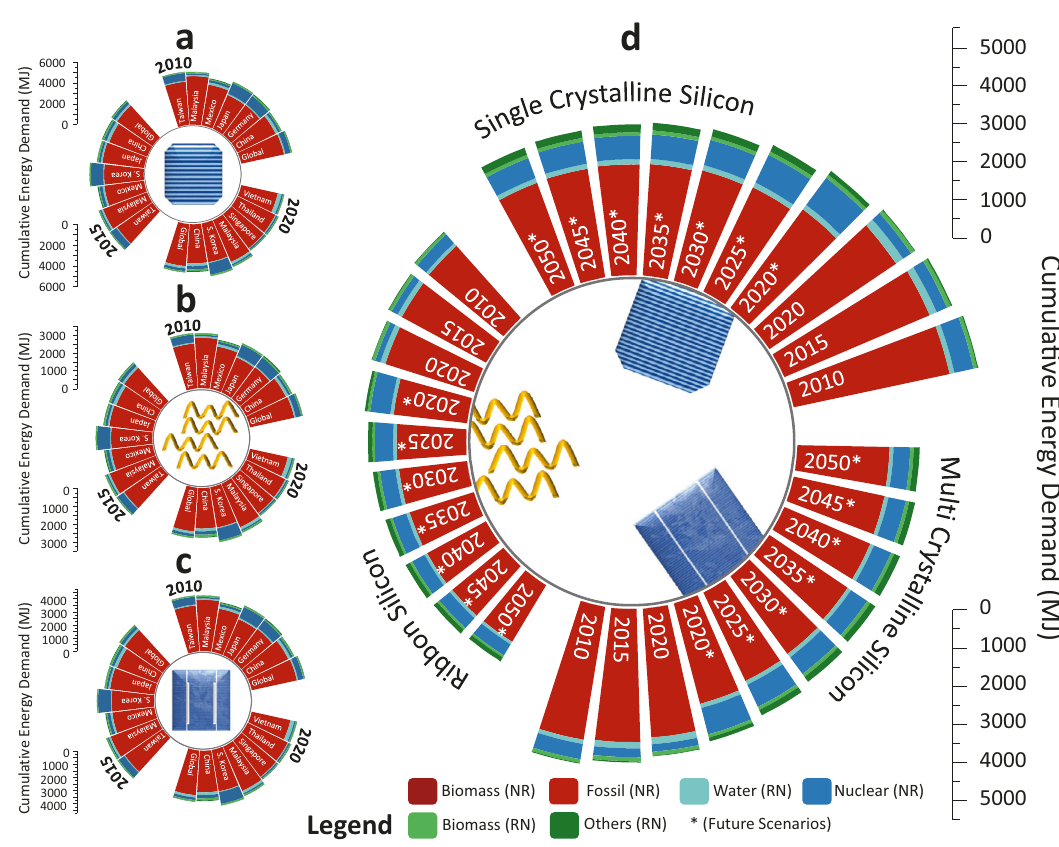
Fig. 4 | Impact analyses of the energy consumption of photovoltaic panel supplies to the U.S. Three cases in 2010, 2015, and 2020 are presented based on three types of crystalline silicon photovoltaic technologies: ( a ) single-crystalline silicon,( b ) ribbonsilicon, ( c )multi-crystalline silicon. a – c representthe energyuse